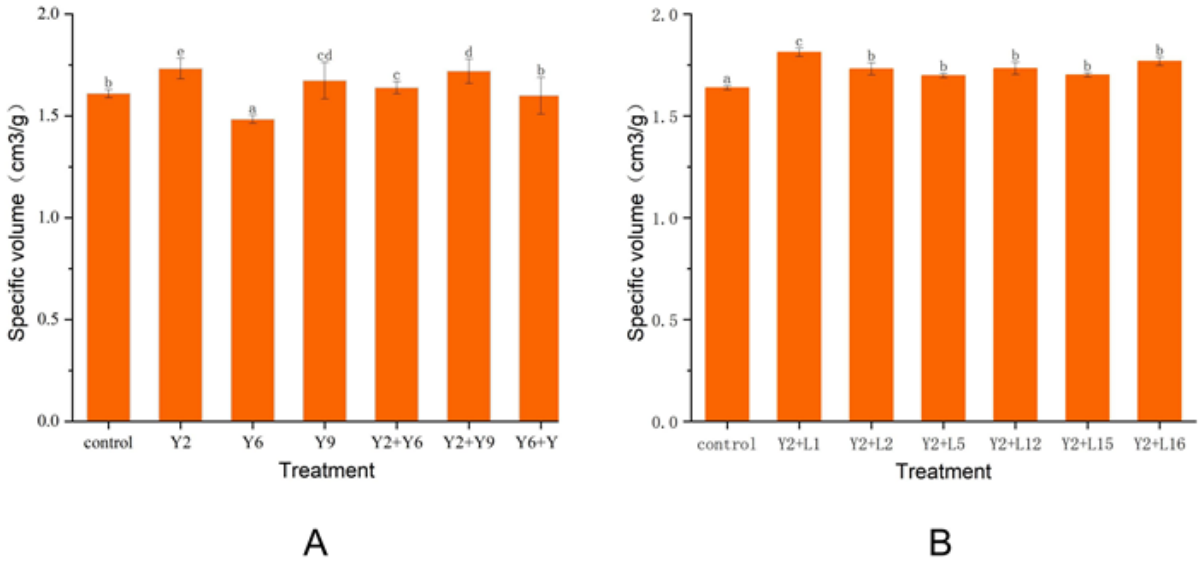
Figure 4. ( A ) Effects of different yeast combinations on the quality of whole wheat steamed